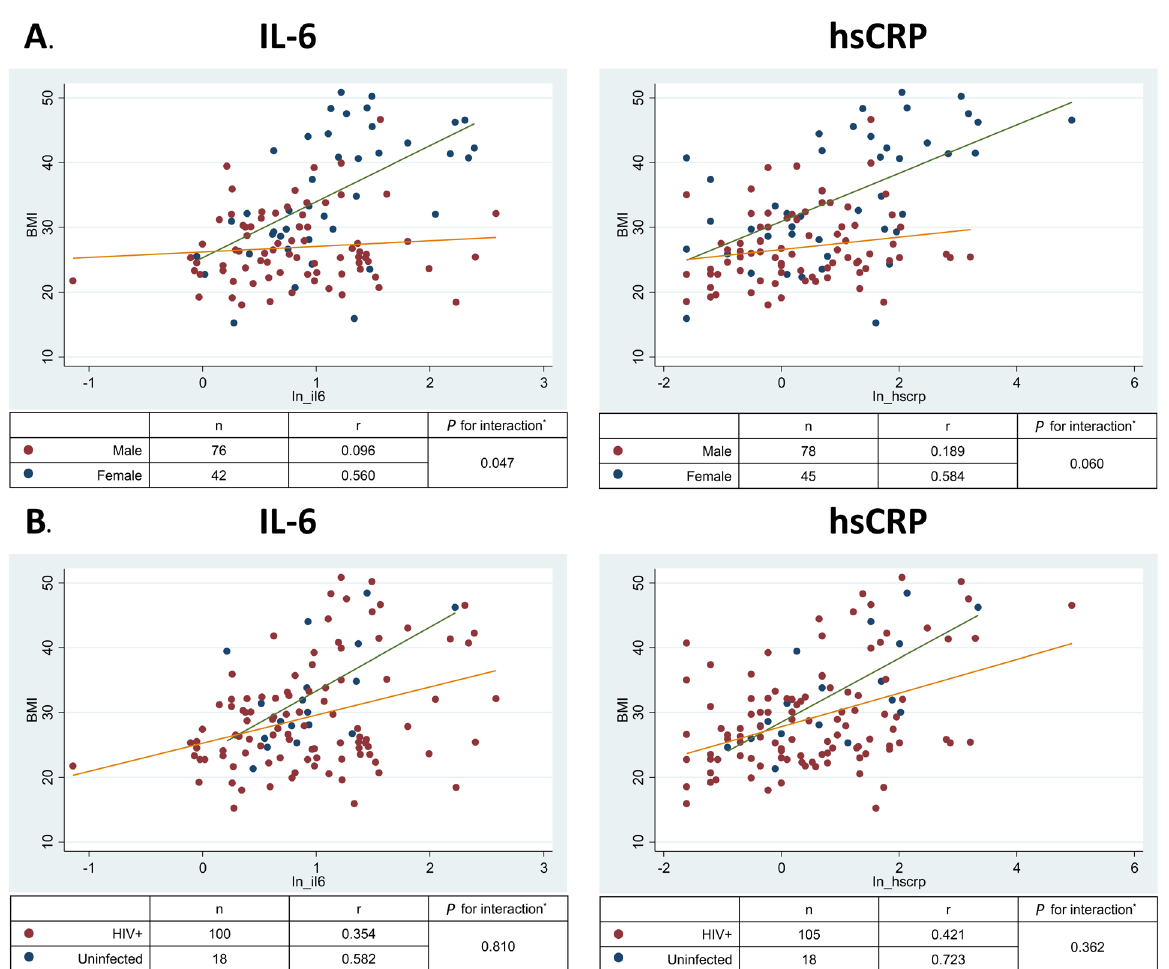
Figure 1. Relationship of BMI with biomarkers of inflammation by (A) sex and (B) HIV status. IL-6, Inter- leukin 6; hs-CRP, high sensitivity C reactive